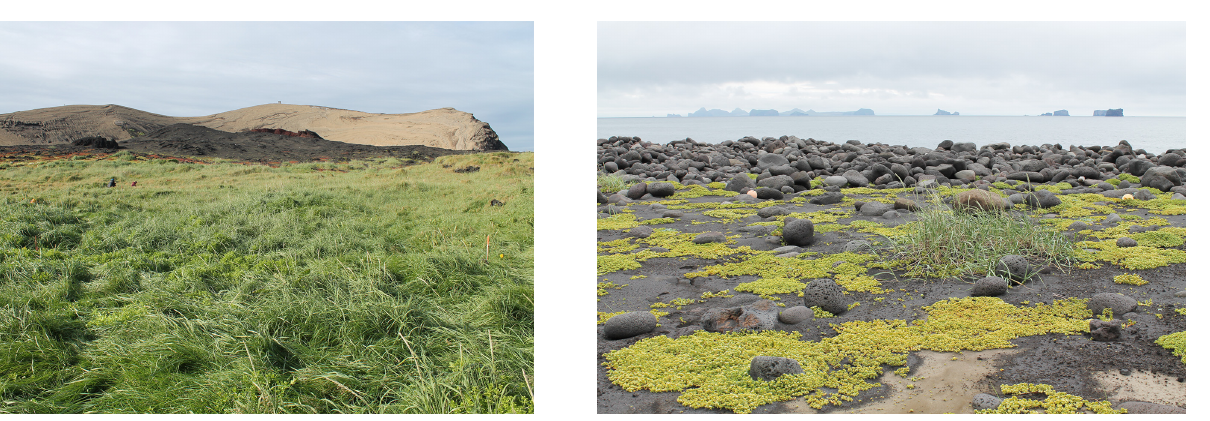
Fig. 4. Shoreline vegetation on the north sand spit of Surtsey (Photo: BM 2013).